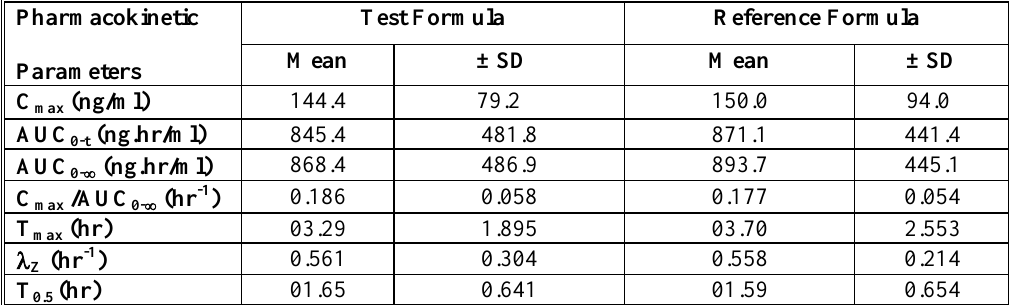
Table (3): Pharmacokinetic parameters of pentoxifylline after a single dose administration of a test formulation (extended- release tablet containing 400 mg pentoxifylline) and the reference formulation (Trental ® extended- release tablet containing 400 mg pentoxifylline) to 32 healthy male adult subjects under fasting condition. Mean ±